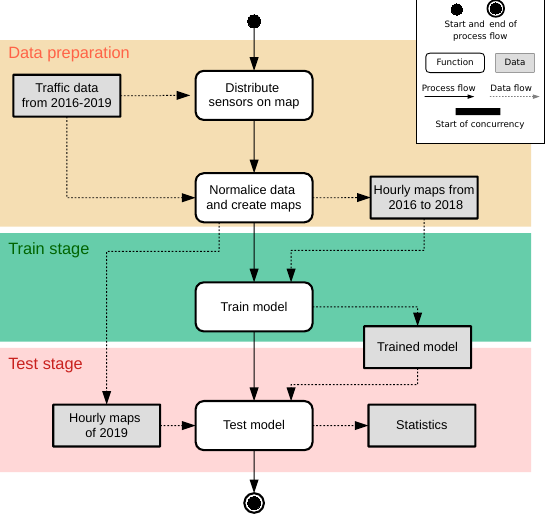
Figure 4. UML activity diagram of the process used to train and test the network models.